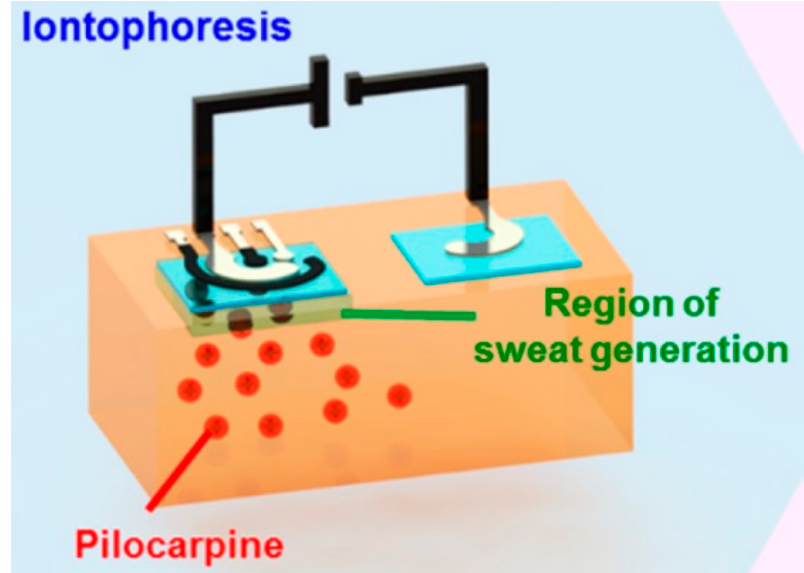
Figure 1. Schematic diagram of an iontophoretic-sensing tattoo device, containing the iontophoretic electrodes (IEs; anode and cathode) and three sensing electrodes (working, reference, and counter electrodes: WE, RE, and CE, respectively). Reprinted with permission from [12]. Copyright (2016), American Chemical Society.